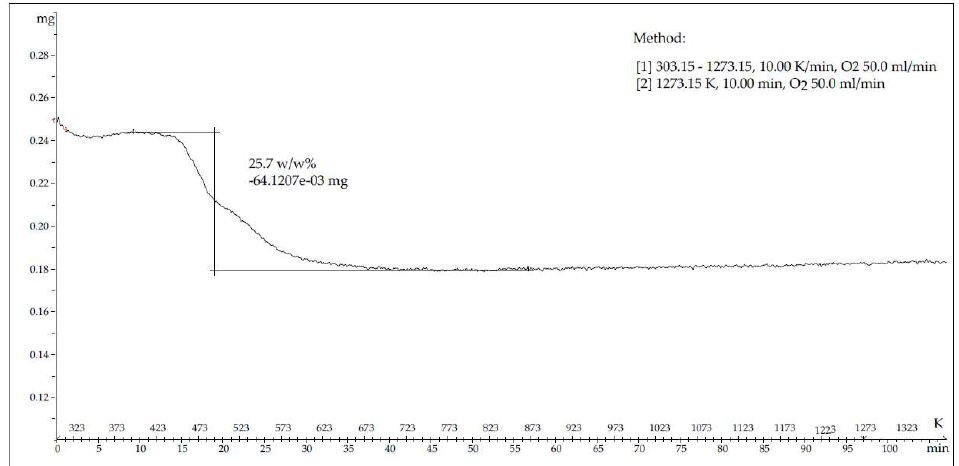
Figure A1. TGA analysis of a dried sample of SC-SPIONs with GA-PEG ligands before dialysis in dextran. The sample was heated up under oxygen atmosphere at 10 K/min and the weight loss was recorded as a function of temperature. The remaining mass of inorganic material was 74.3%.